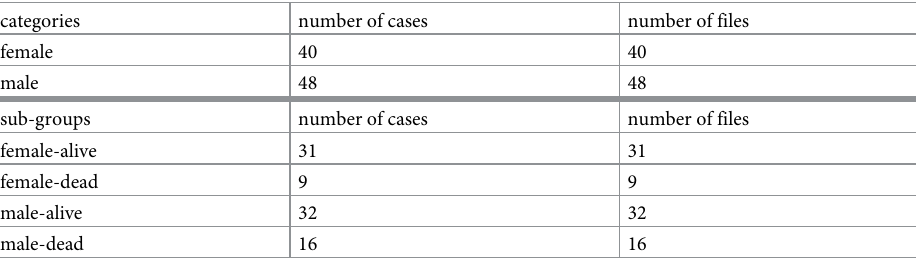
Table 1. Data set for